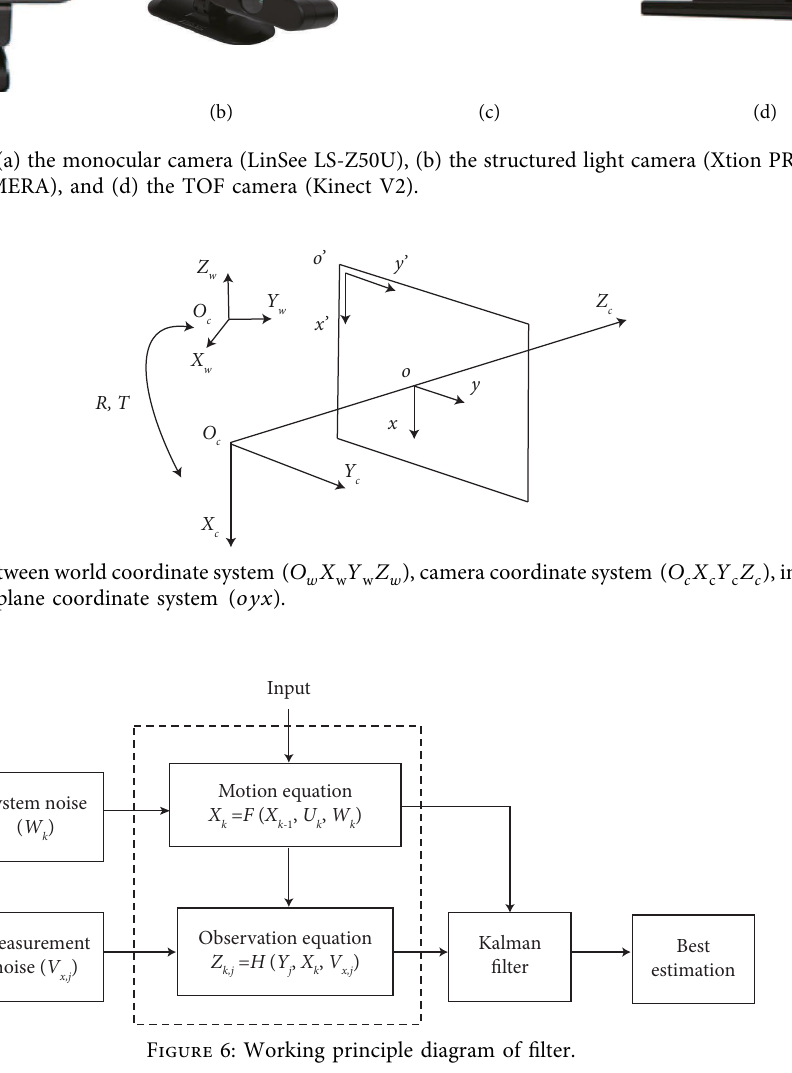
Figure 6: Working principle diagram of